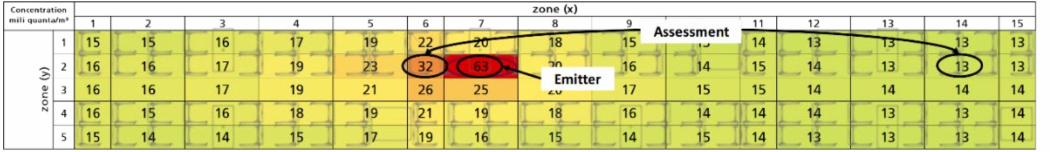
Figure 3. Example of evaluation/representation of the simulation: shown is the concentration in mili-quanta/m 3 in a section through the compartment at breathing